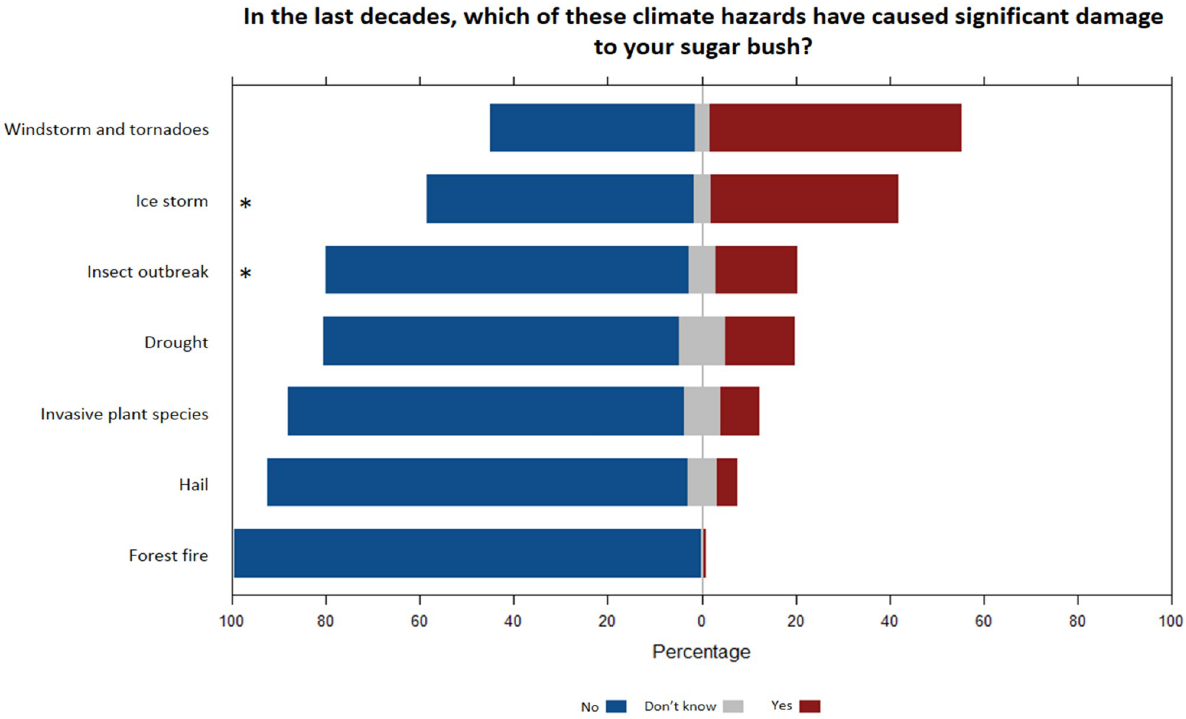
Fig 5. Exposure to past climatic events. Responses of the survey participants for the question In the last decades , which of these climatic events have caused significant damages to your sugar bush ? Statements followed by a � symbol indicate a significant effect of at least one predictor (see Table 3 and Supplementary Material